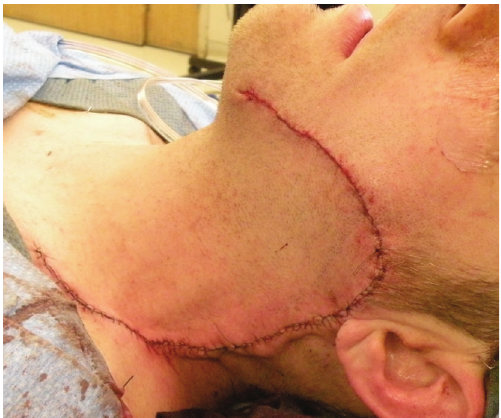
Figure 4: The surgical defect was reconstructed with cervicofacial advancement